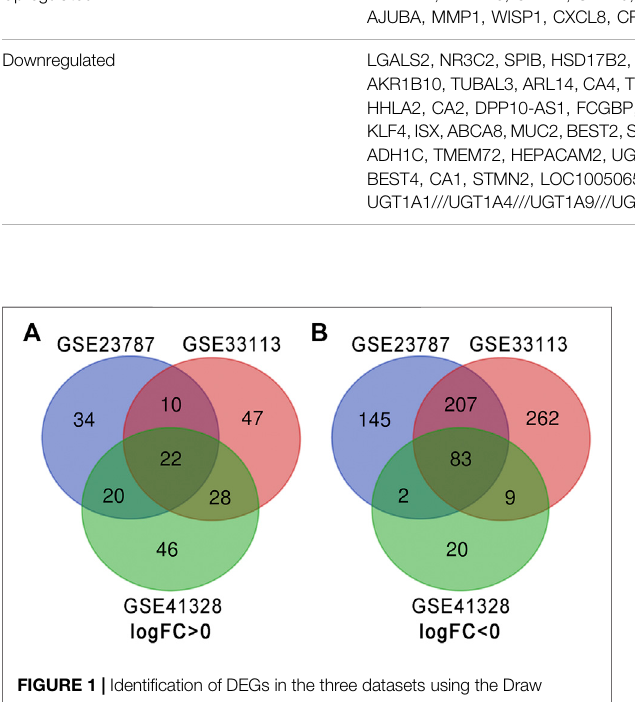
TABLE 1 | The 105 common DEGs were identi fi ed from the three gene expression pro fi le datasets. DEGs Gene names Upregulated